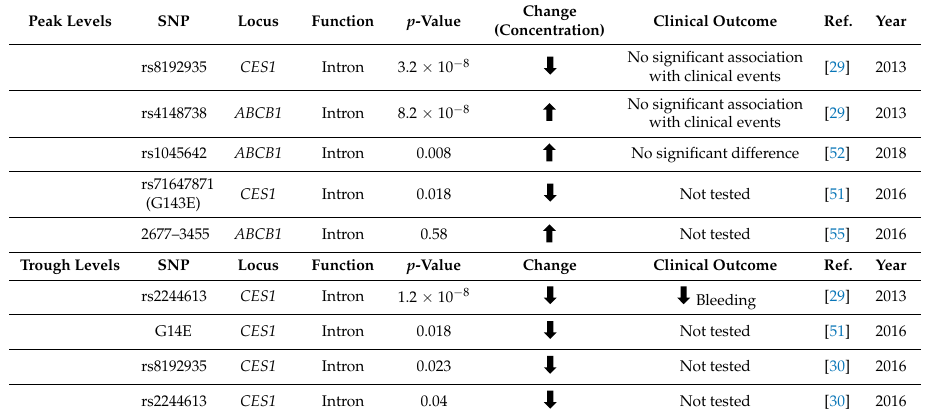
Table 1. Common genetic variants associated with pharmacodynamics and pharmacokinetics of dabigatran.